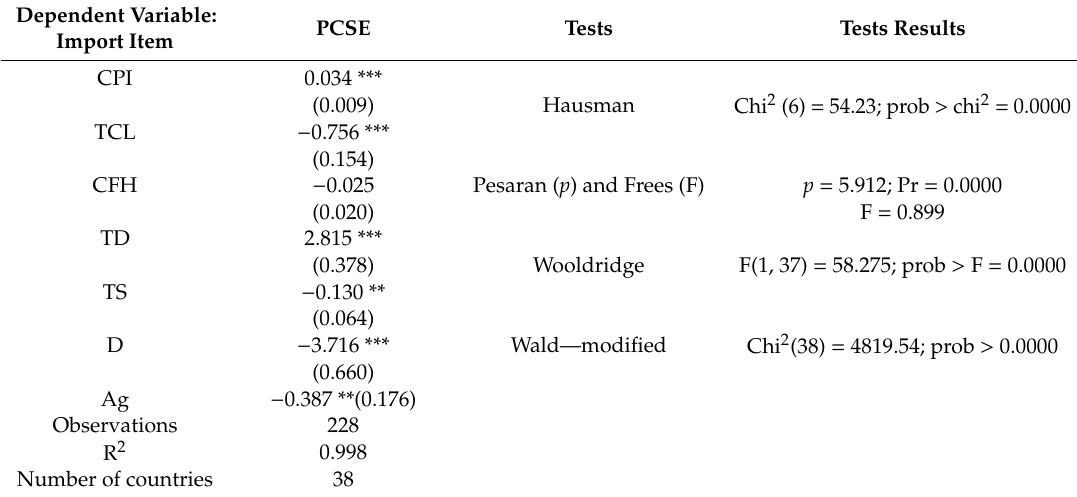
Table 5. Panel data